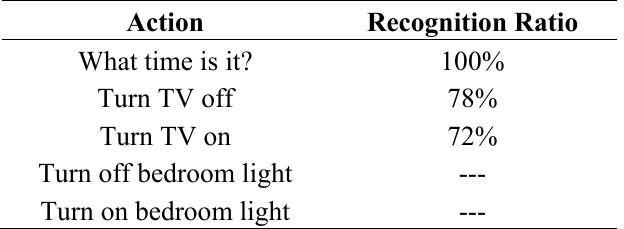
Table 2. Results for voice commands using Android speech